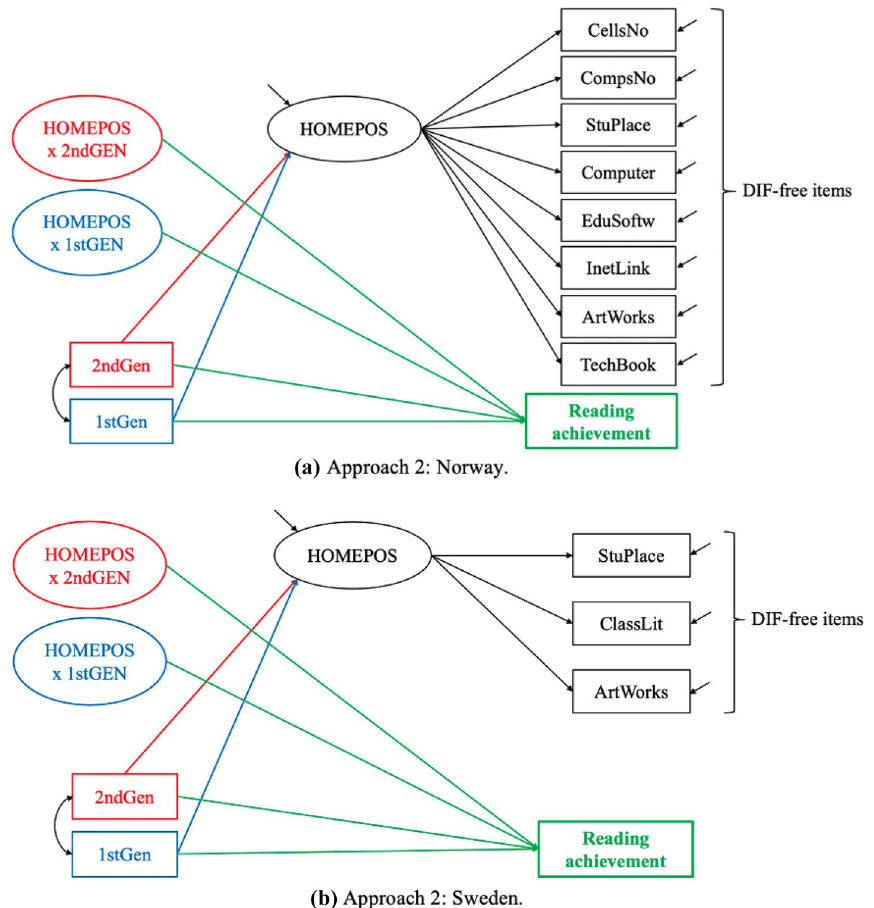
Fig. 4 Quantifying the HOMEPOS–reading achievement relationship after deleting non-comparable items: a HOMEPOS measurement model in the Norwegian sample is represented by comparable items—items that do not exhibit uniform or non-uniform DIF; b HOMEPOS measurement model in the Swedish sample is represented by comparable items—items that do not exhibit uniform or non-uniform